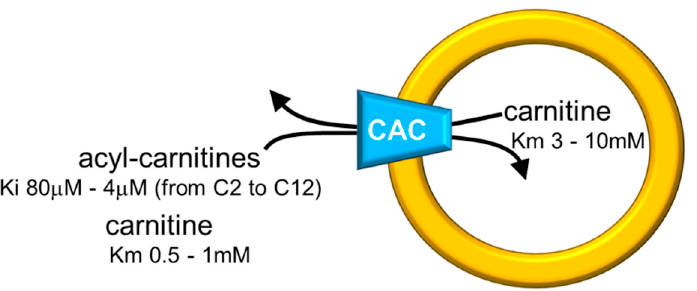
Figure 2. Sketch of the proteoliposome model with reconstituted CAC. Proteoliposomes contained 4% cardiolipin. Range of inhibition constants (Ki) for acyl-carnitines of various chain lengths on the external side and ranges of carnitine Km on both sides of CAC are reported.